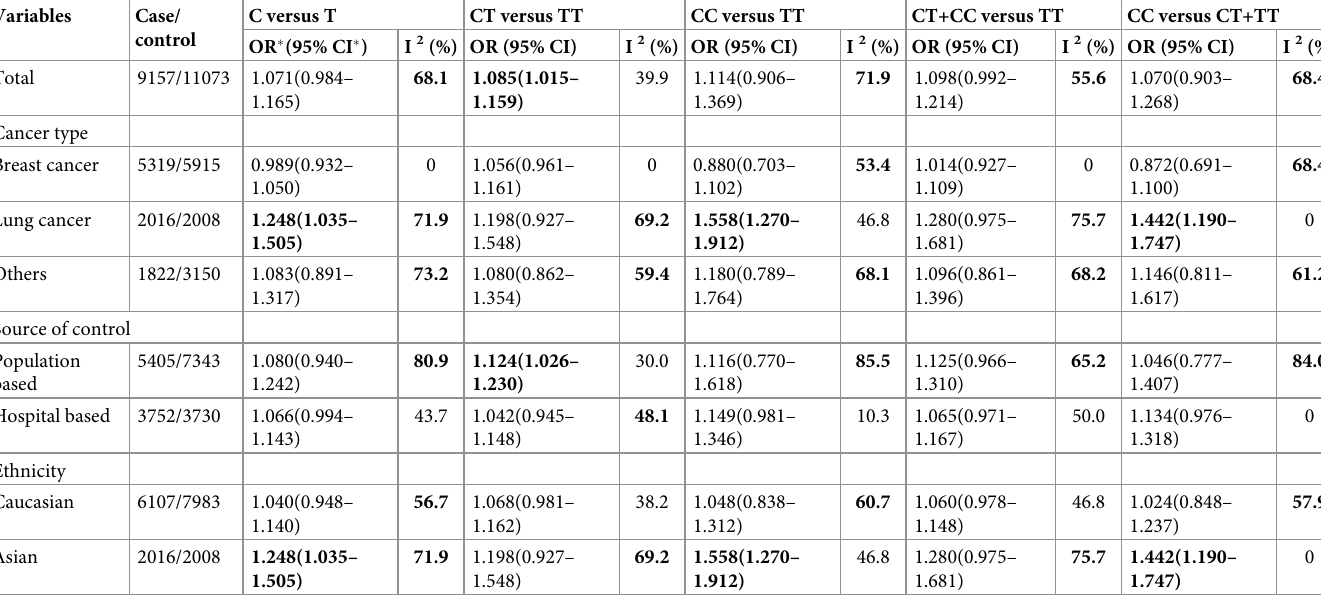
Table 2. Summary of pooled ORs in the stratified analysis association between TERT rs2853669 and cancer